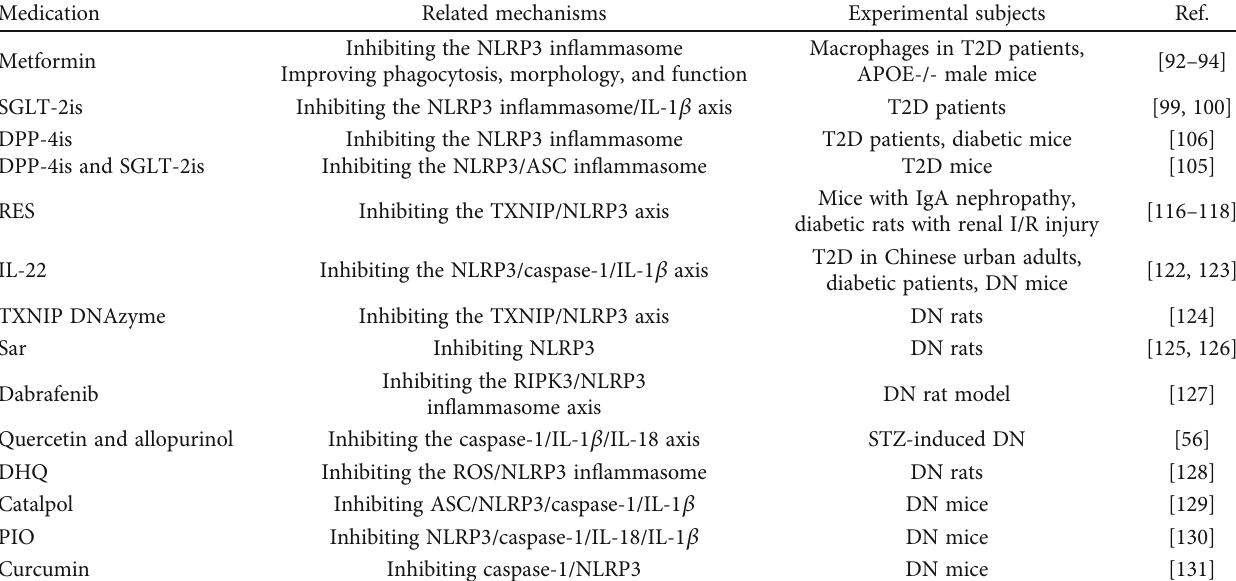
Table 2: The partly regulation role of drugs that target the NLRP3 in fl ammasome in DN treatment.